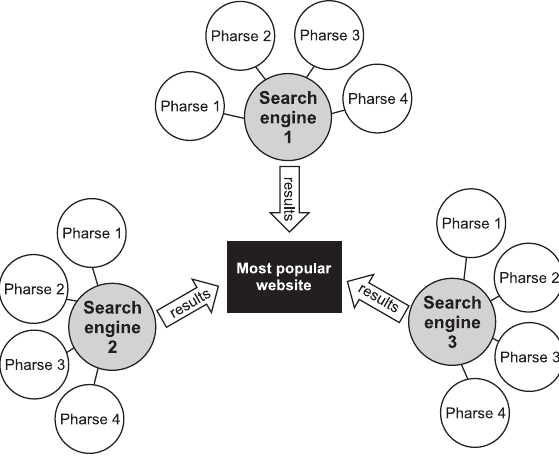
Fig. 1. Scheme of the search engine method applied in the